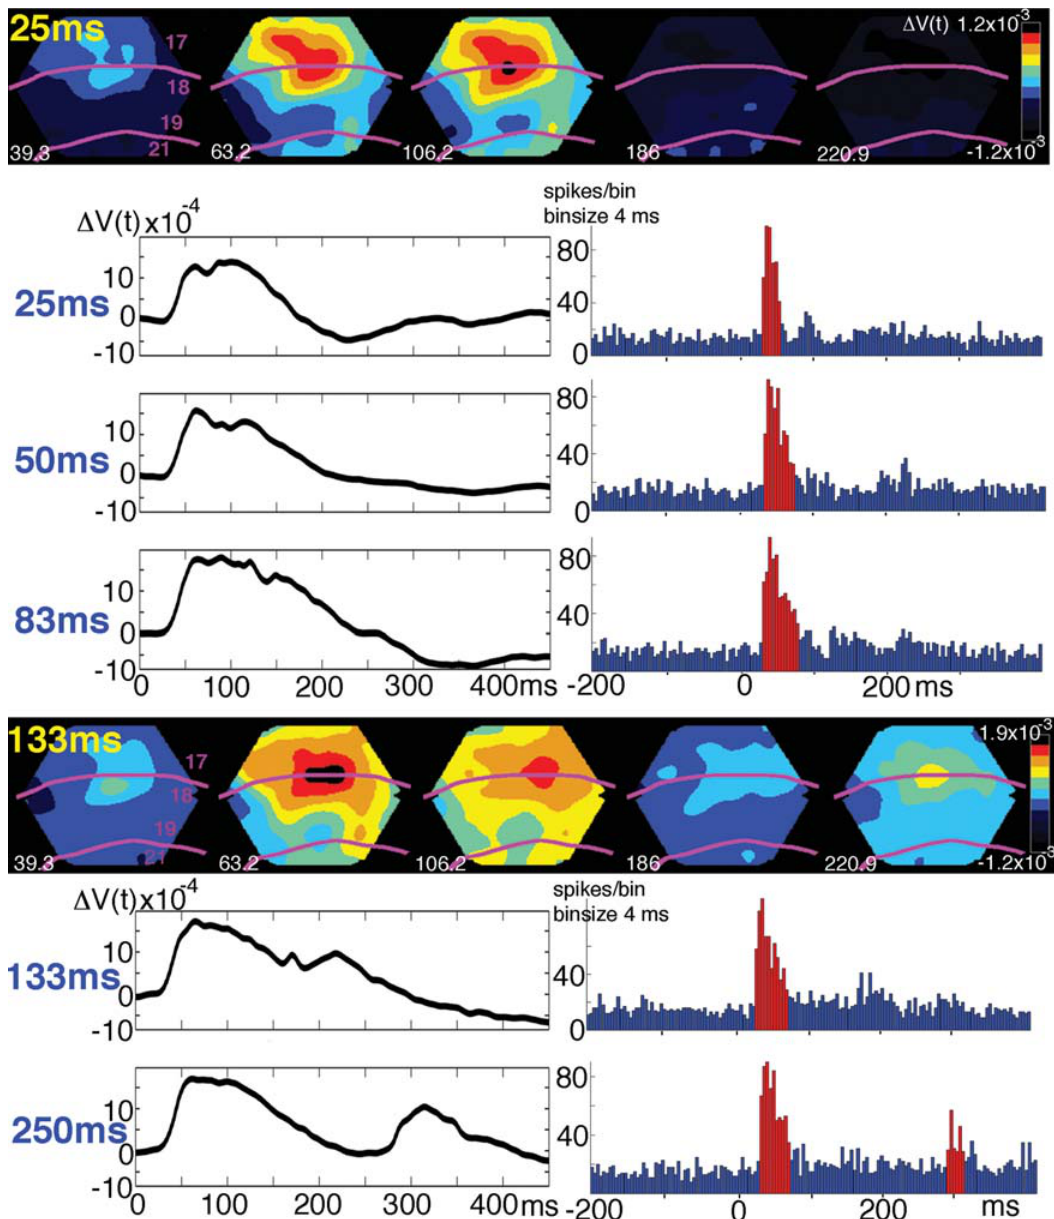
Figure 2. Voltage sensitive dye signal and multiunit activity for different stimulus conditions. Animal 5. The colored panels show the spatial distribution of the D V(t) for stimulus durations 25 ms and 133 ms at different times after stimulus onset as indicated in ms for each frame shown. The borders of the cytoarchitectural areas are marked with magenta; these borders mark also the vertical meridians. The black curves show the mean D V(t) from the square representation site at the cytoarchitectural border between areas 17 and 18 for each of the stimulus conditions. Note that all significant (p , 0.01) D V(t) increases outlasts the stimulus by more than 100 ms. The post stimulus histogram from a single recording site at the square representation at the 17/18 border is shown corresponding to the stimulus duration indicated to the left. Note the truncation of the ON response at 25 ms giving a significant firing duration of 24 ms (significant firing p , 0.01 marked with red bins), and the response to 50 ms giving a significant firing duration of 48